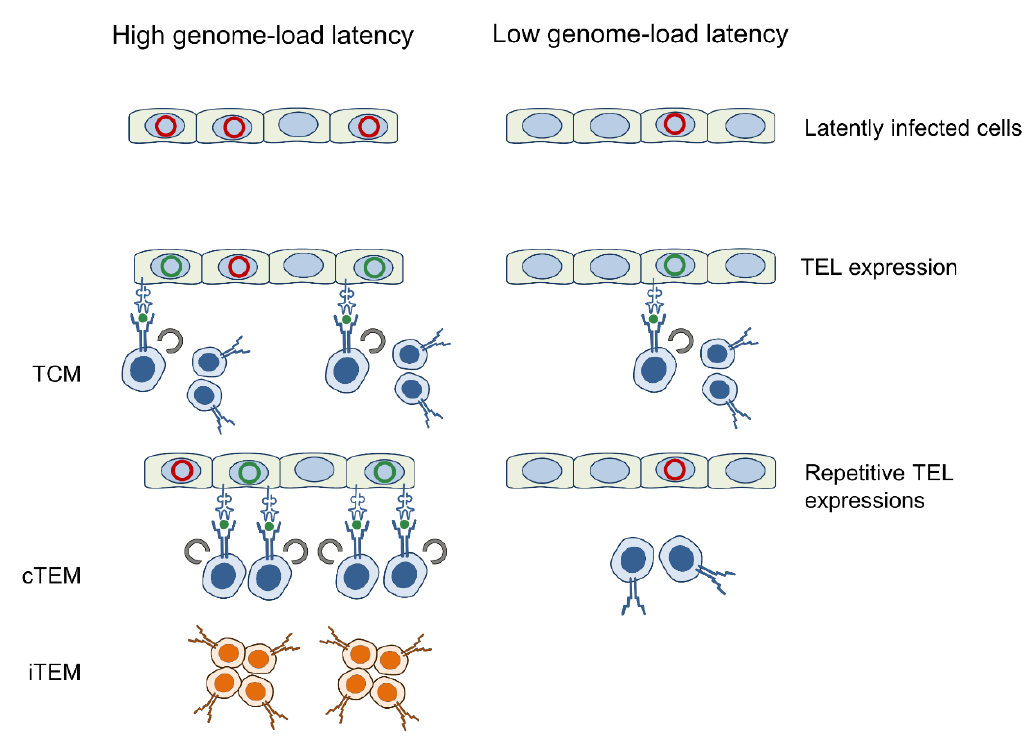
Figure 8. Concluding hypothesis. For detailed explanation, see the section ‘Discussion’. Red circles: Silenced viral genomes in the nucleus of latently infected cells. Green circles: Latent viral genomes transcriptionally desilenced at a gene locus coding for an antigenic peptide. Receptor symbols on latently infected cells and memory CD8 T cells represent peptide-loaded MHC-I molecules and TCR, respectively.